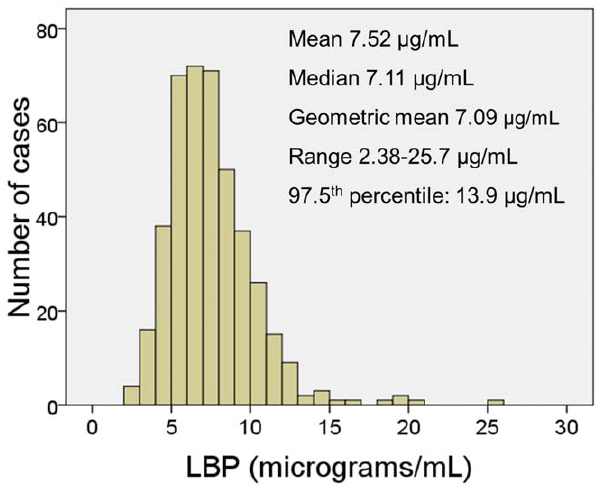
Figure 1. Histogram of serum concentrations of lipopolysac- charide-binding protein (LBP) in the study population.